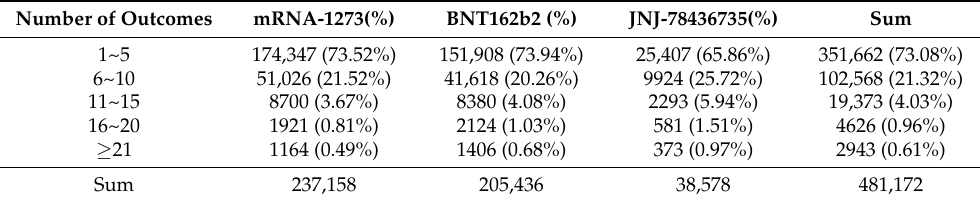
Table 5. Number of outcomes for individuals according to 5 levels of number of adverse events for each